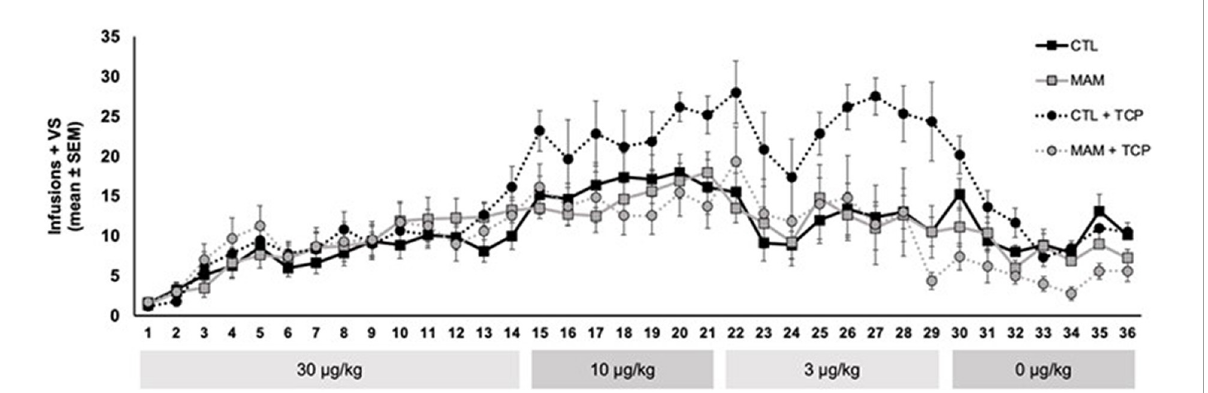
FIGURE3 Effect of MAO inhibition on nicotine self-administration in MAM vs. control (CTL) rats. Adult MAM and CTL rats were injected with TCP (1.0 mg/kg, i.p.) or vehicle 1 h prior to behavioral sessions. Each group was 7–8 rats and included approximately equal numbers of males and females. Rats were allowed to self-administer nicotine (30 µ g/kg, i.v.) paired with a mildly reinforcing visual stimulus (VS) in daily 1-h behavioral sessions 5 days per week for 14 sessions. Descending doses of nicotine (10, 3, and 0 µ g/kg) were self-administered for 7–8 sessions and catheter patency was confirmed at the end of each dose phase (for details related to the MAM rats and the self-administration protocol, see Weeks et al., 2020). (This study was approved by the University of Pittsburgh Animal Care and Use Committee and were conducted in accordance with the NIH Guide for the Care and Use of Laboratory